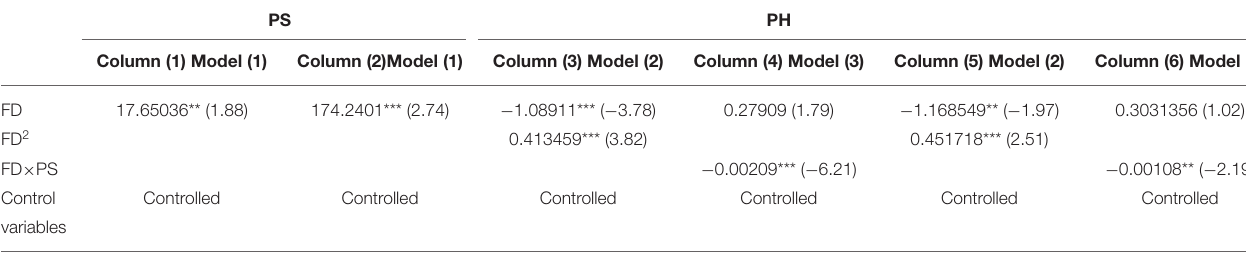
TABLE 5 | More control variable results using FGLS.